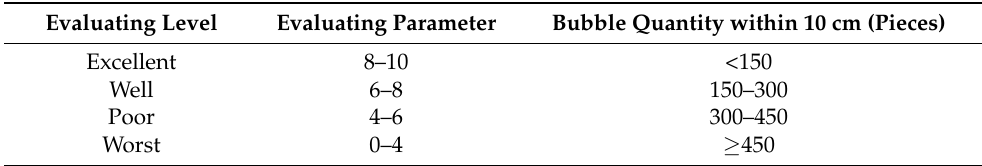
Table 5. Evaluation basis for bubble quantity at the sealing edge.